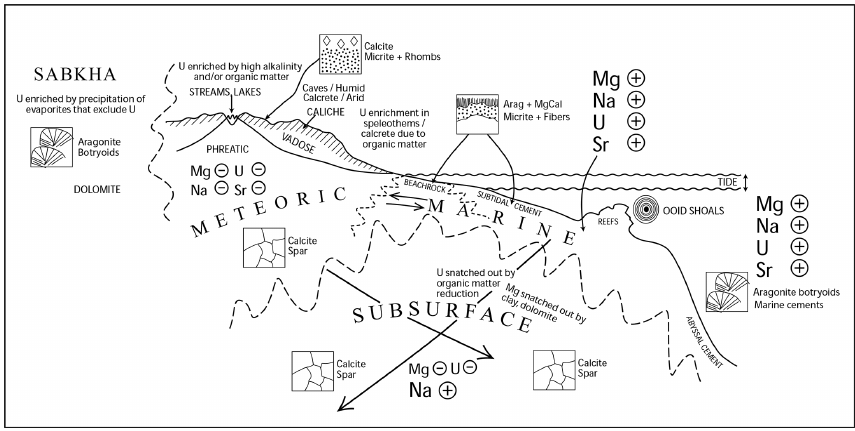
Figure 1. Cartoon of the variety of carbonate-producing environments, with arrows indicating the direction the elements would change through diagenetic alteration (Rasbury and Cole, 2009). We would like to see U concentrations and oxidation states be an important compo- nent in understanding fluids and